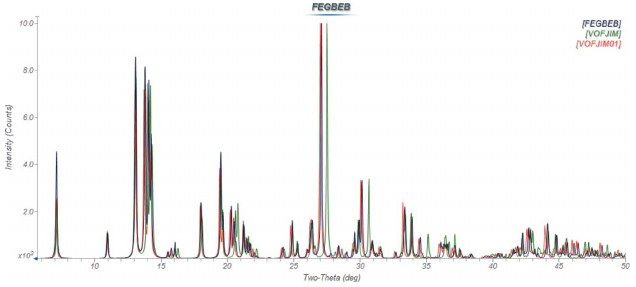
Figure 1 Calculated (using Mercury; Macrae et al. , 2020) powder diffraction patterns (Cu K (cid:2) radiation) for CPO-27-Co [FEGBEB (Gen, 2017), VOFJIM (Rosnes et al. , 2019) and VOFJIM01 (Ayoub et al. , 2019)]. The differences in peak positions result from the different temperatures of the diffraction studies. Image generated using JADE Pro (MDI, 2022).